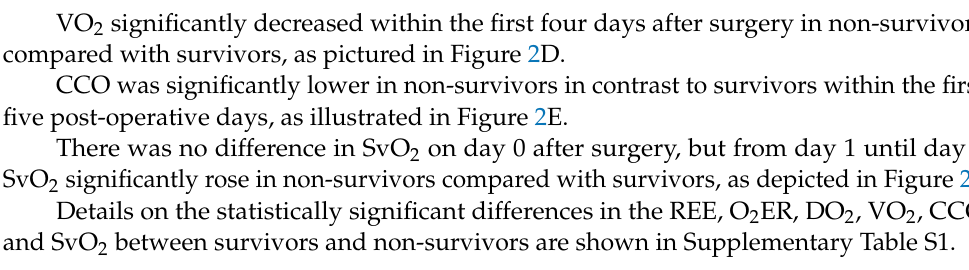
Figure 2. CCO, SvO 2 , DO 2 , VO 2 , O 2 ER and REE of survivors and non-survivors during the first seven days. In non-survivors, the REE median was significantly reduced compared with survivors values on post-operative days 2, 3, 4 and 6 compared with survivors after heart surgery ( B ). DO 2